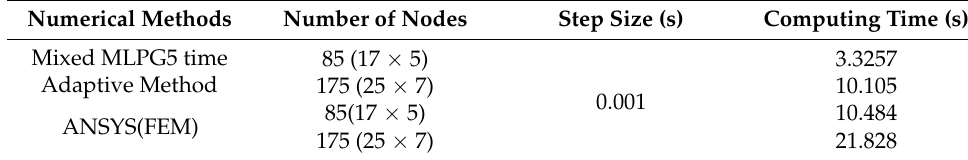
Figure 23. The transient vertical displacement at point A with damping ( 𝑐 = 10 Ns/m ) and Δ𝑡 = ∆ t = 0.001 s under transient loading with finite decreasing time. 0.001 s under transient loading with finite decreasing time. Table 3. Computing time of two algorithms. Table 3. Computing time of two